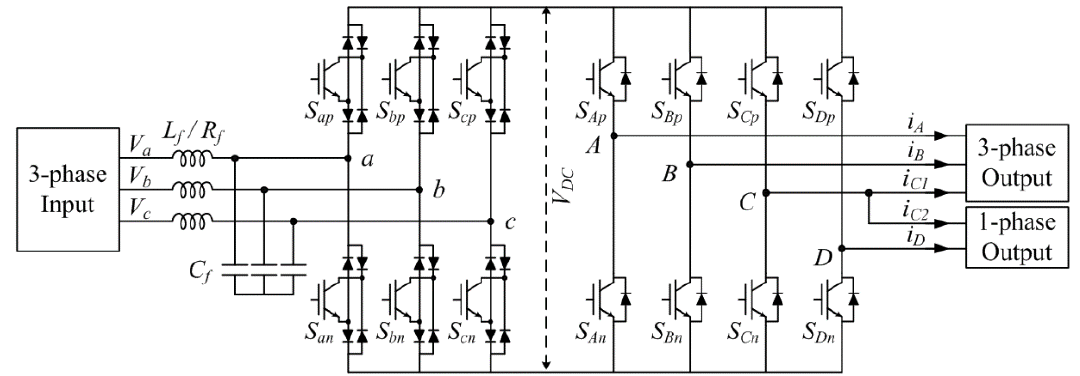
Figure 4. Proposed dual output drive system based on VSMC for hybrid electric vehicle